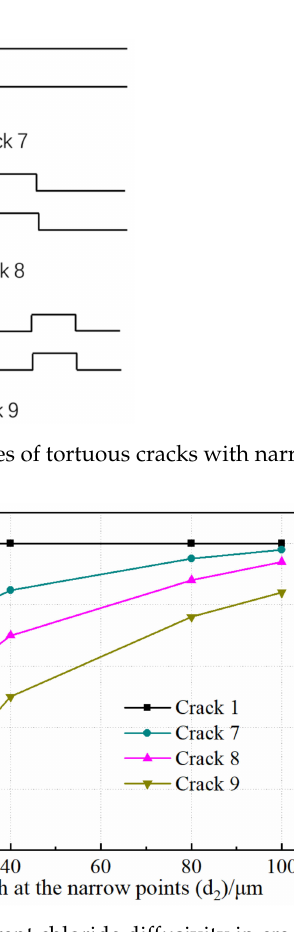
Figure 6. The apparent chloride diffusivity in cracks with narrow